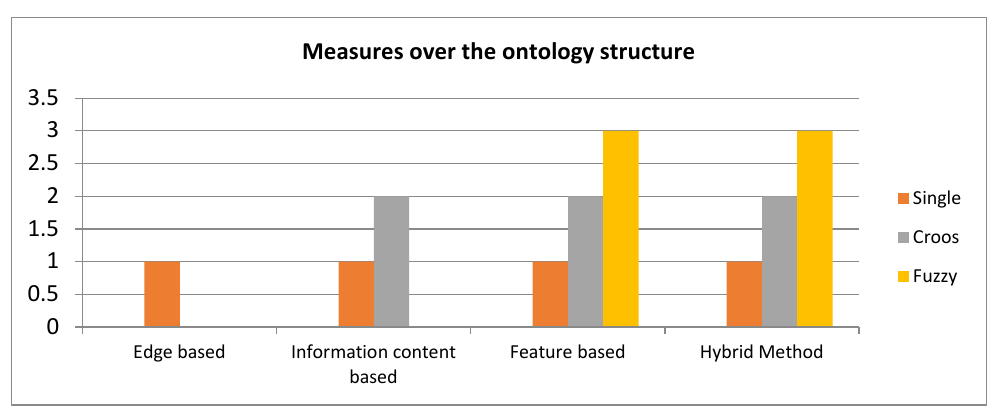
Figure 6 Measures over the Ontology’s